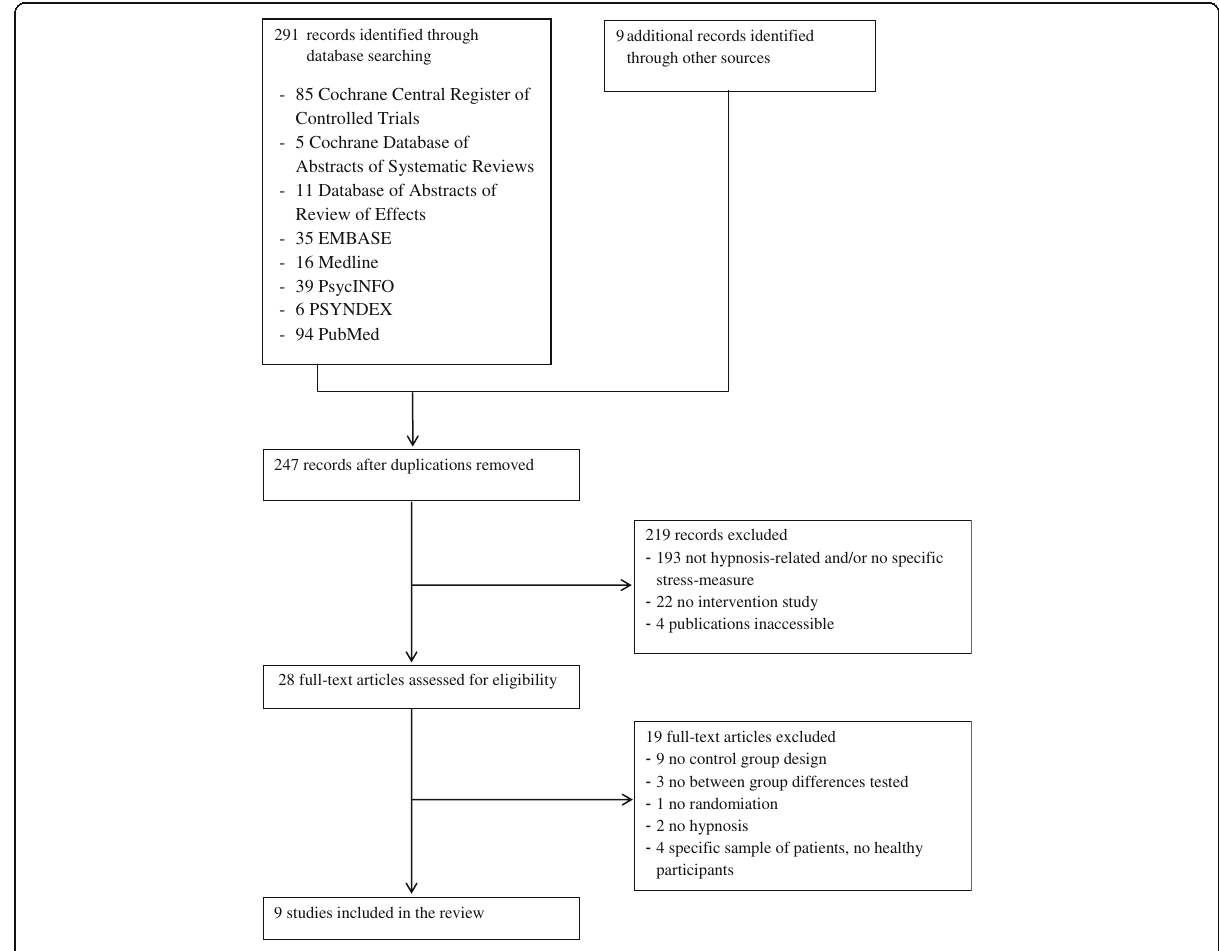
Fig. 1 Flowchart of the results of the literature